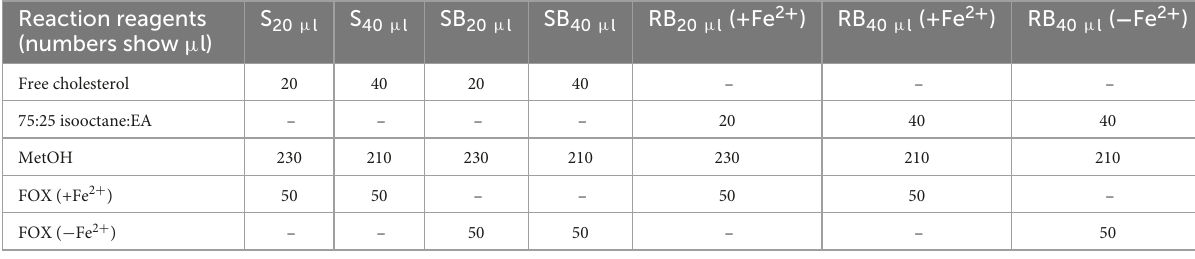
TABLE 3 Assay set up for LOOH determination in LDL free cholesterol. Reaction reagents (numbers show µ